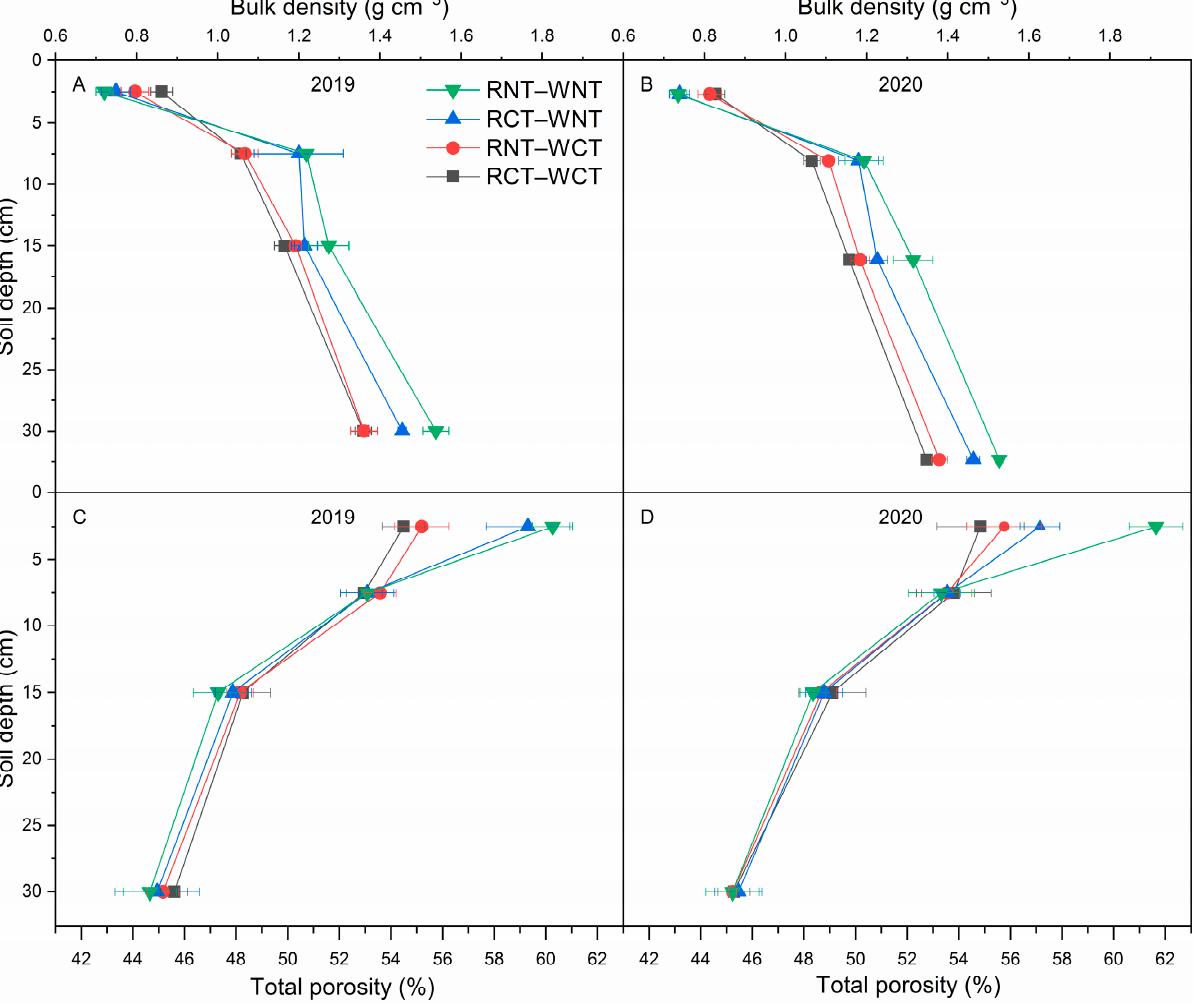
Figure 1. Effects of bulk density (BD, g m − 3 ) in 2019 ( A ) and 2020 ( B ) and total porosity (TP, %) in 2019 ( C ) and 2020 ( D ) under different tillage managements. RCT–WCT, conventional tillage before transplantation/sowing of each crop; RNT–WCT, no tillage before transplantation of rice and con- ventional tillage before sowing of wheat; RCT–WNT, conventional tillage before transplantation of rice and no tillage before sowing of wheat; RNT–WNT, no tillage before sowing of each crop. Dif- ferent lowercase letters indicate statistical differences among treatments at p < 0.05.